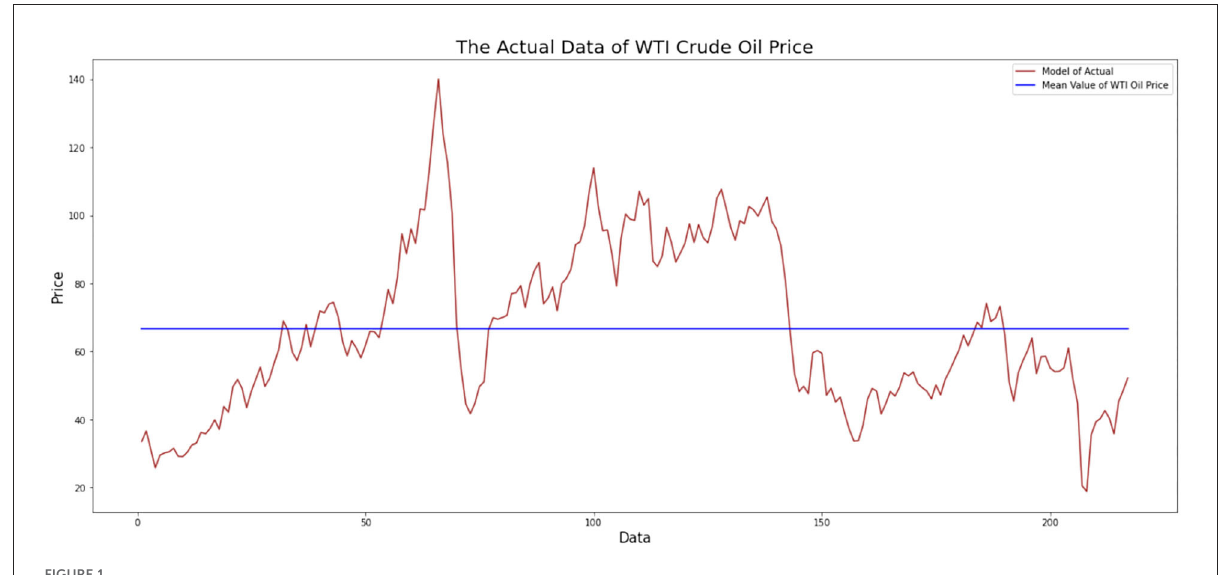
FIGURE1 WTI oil price monthly data